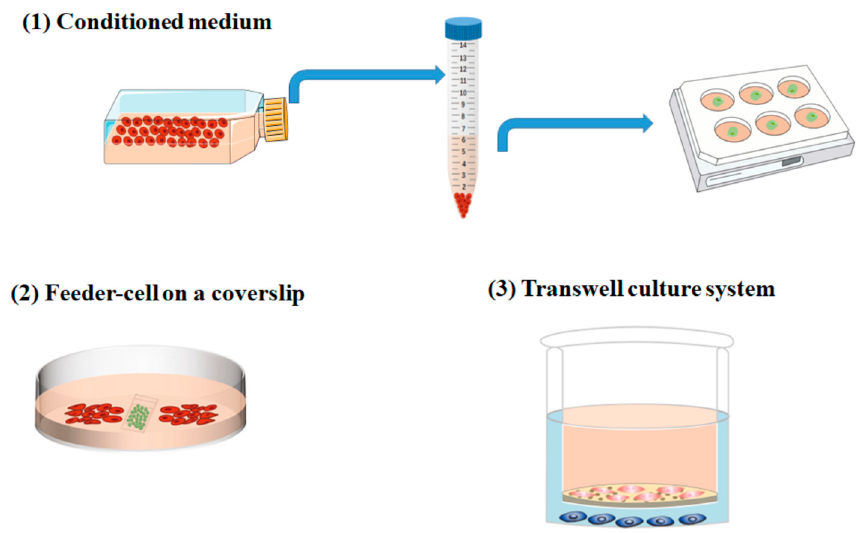
Figure 1. The way to achieve indirect contact co-culture: indirect contact co-culture is the cultivation of two or more different cell types so that the cells interact with each other through the chemical factors within the culture medium and without physical direct contact. The ways to achieve this may include ( 1 ) Conditioned medium: cell culture supernatant which contains various growth factors or stimuli secreted by cells is collected to investigate the effects of factors on cell growth or differentiation. ( 2 ) Feeder-cell on a coverslip: cells that secreted certain factors can also be plated on a coverslip to avoid direct contact with the cells plated in a Petri dish. ( 3 ) Transwell culture system: cell co-culture system in a transwell chamber.